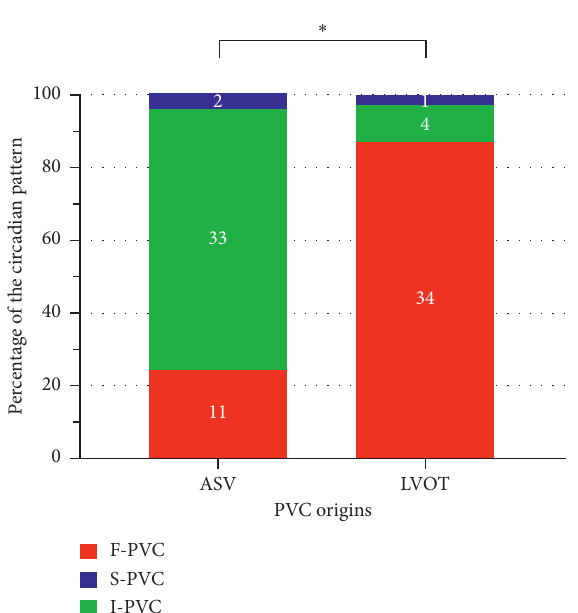
Figure 4: Differences in circadian patterns between ASV and LVOT PVCs. Circadian pattern distributions for ASV and LVOT PVCs. ∗ Indicates p < 0 . 05. ASV, aortic sinus of Valsalva; LVOT, left ventricular outflow tract; PVC, premature ventricular complexes.